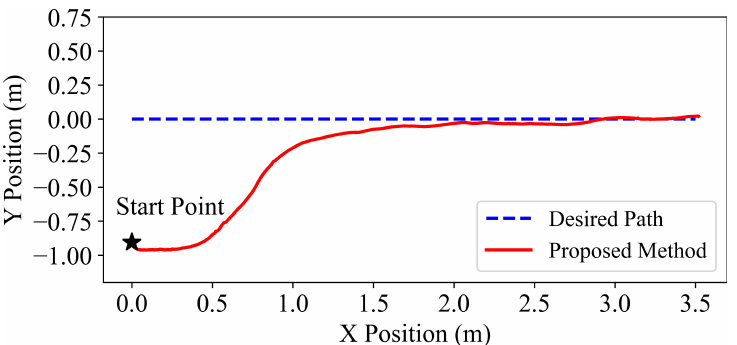
Figure 7. Path following results of the desired line for the proposed hierarchical method.